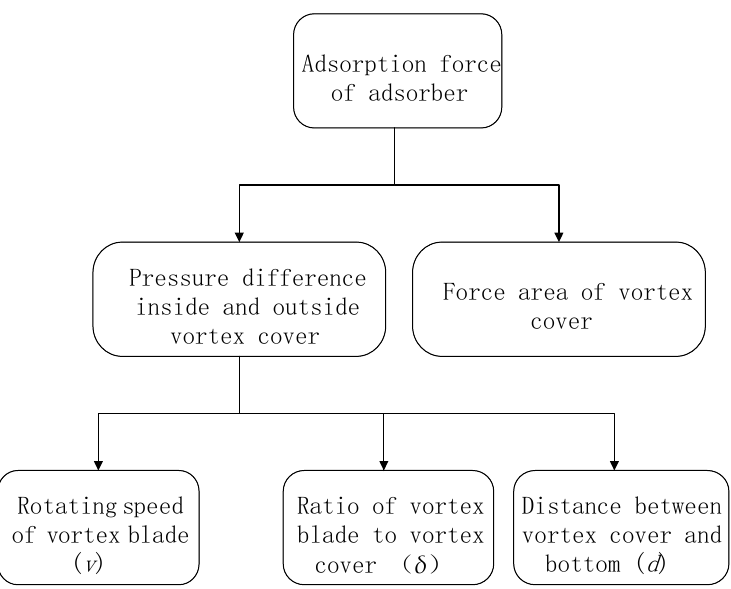
Figure 3. Factors influencing adsorption performance.